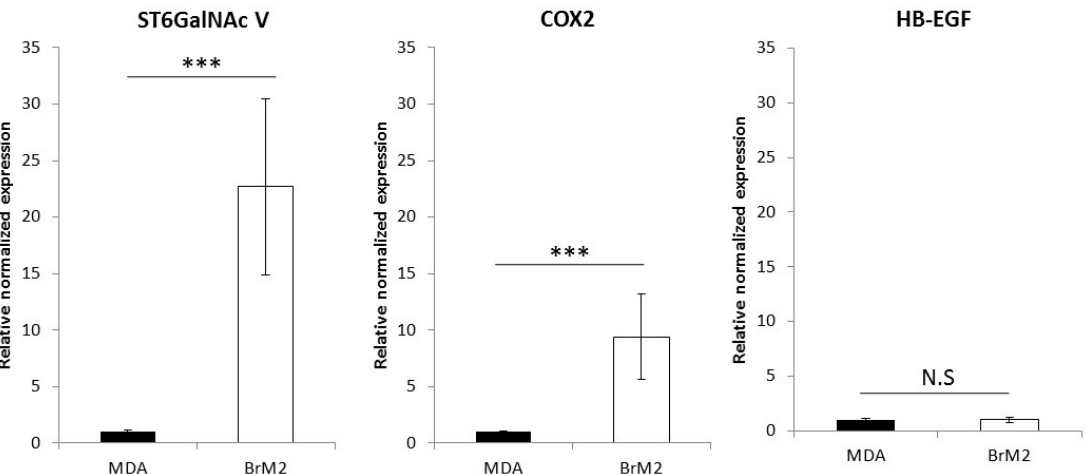
Figure 2. qPCR analysis of COX2 , HB-EGF , and ST6GALNAC5 in MDA-MB-231 wt and BrM2. Quantification was performed by the method described by Pfaffl [17] and normalized to Actin. N.S: not significant; *** p < 0.001.